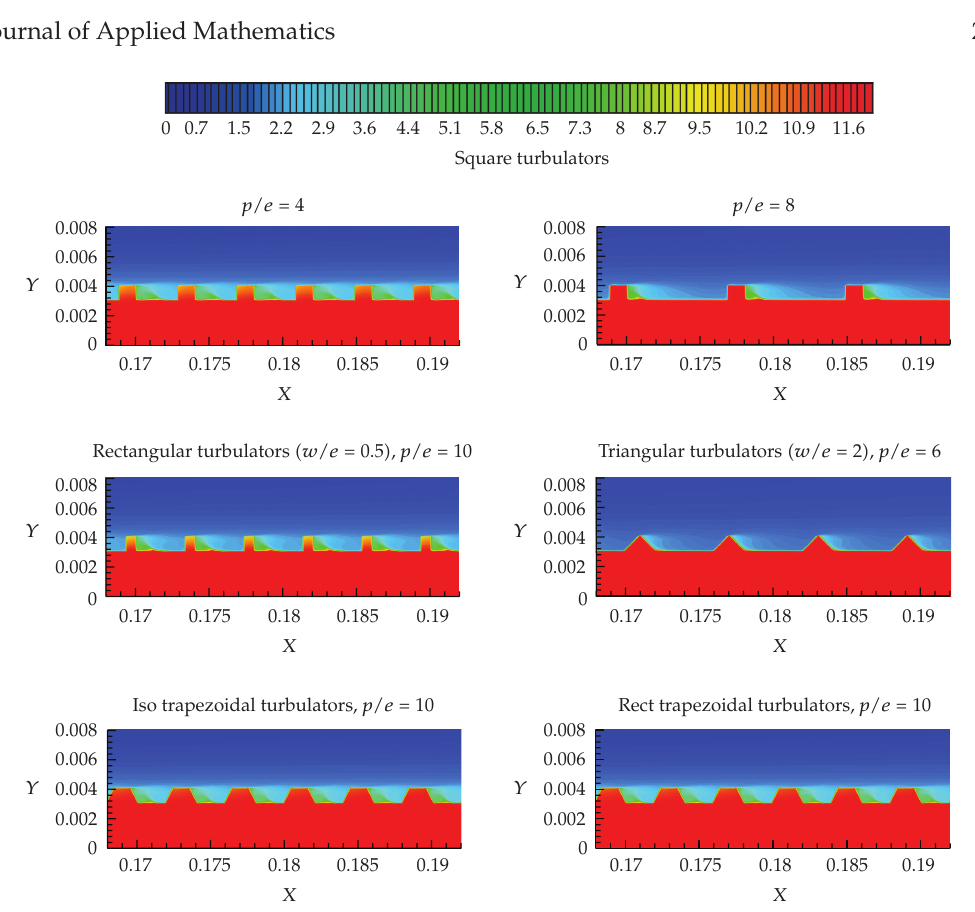
Figure 14: Temperaturefields at Re (cid:8) 50000 and di ff erent significant pitches, for square, rectangular (cid:6) w/e (cid:8) 0 . 5 (cid:7) , triangular (cid:6) w/e (cid:8) 2 . 0 (cid:7) and trapezoidal ribs, e/d (cid:8) 0 . 05. p/e (cid:8) 8. In the figure on the left, the fluid temperature is very high near the rib-wall juncture behind the turbulator but the fluid in the core region is poorly influenced, because of the recirculation entrapped into the interrib zone. For p/e (cid:8) 8, such as for a configuration which exhibits a k-type behaviour, the mixing e ff ects are stronger and the average temperature also in the core region is higher; as a result, the di ff erence between the average temperature of fluid and wall decreases and the heat transfer mechanism becomes more e ffi cient, as also described for the rectangular shape (cid:6) w/e (cid:8) 0 . 5 (cid:7) at p/e (cid:8) 10, iso and rect trapezoidal turbulators at p/e (cid:8) 10. The triangular elements show the best thermal performances also for low